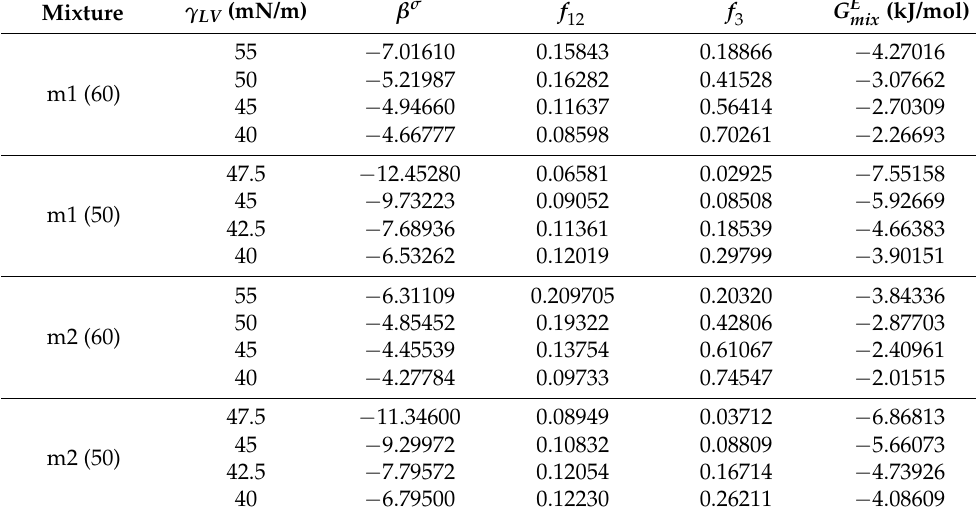
Table 2. The values of the parameters of intermolecular interaction, β σ , (Equation (6)) activity coefficients of CTAB + TX100 mixture, f 12 , and fluorocarbon surfactant, f 3 (Equations (8) and (9)) and Gibbs excess free energy of mixing, G E (Equation (7)) of CTAB + TX100 + FC1 (m1 (60), m1 mix (50)) and CTAB + TX100 + FC2 (m2 (60), m2 (50)) mixtures at CTAB + TX100 γ LV equal to 60 and 50 mN/m, respectively, at the different fluorocarbon surfactants’ surface